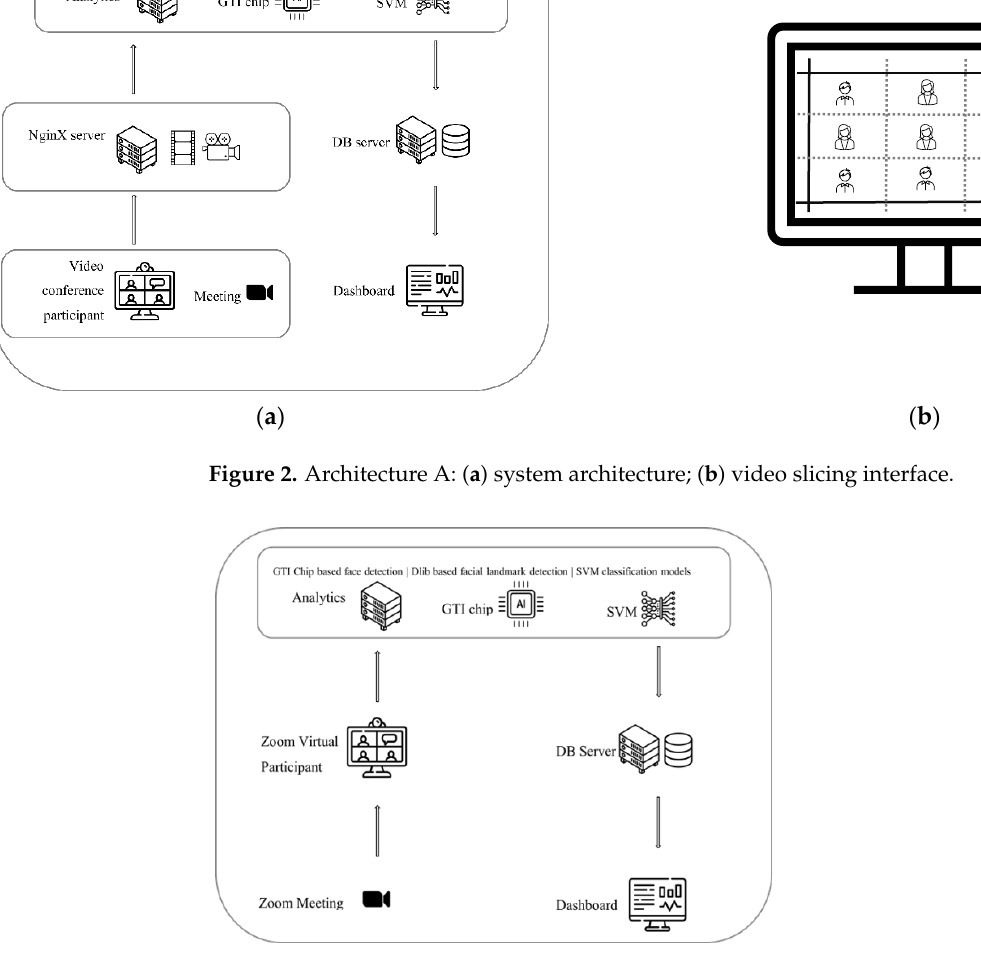
Figure 3. Architecture B system